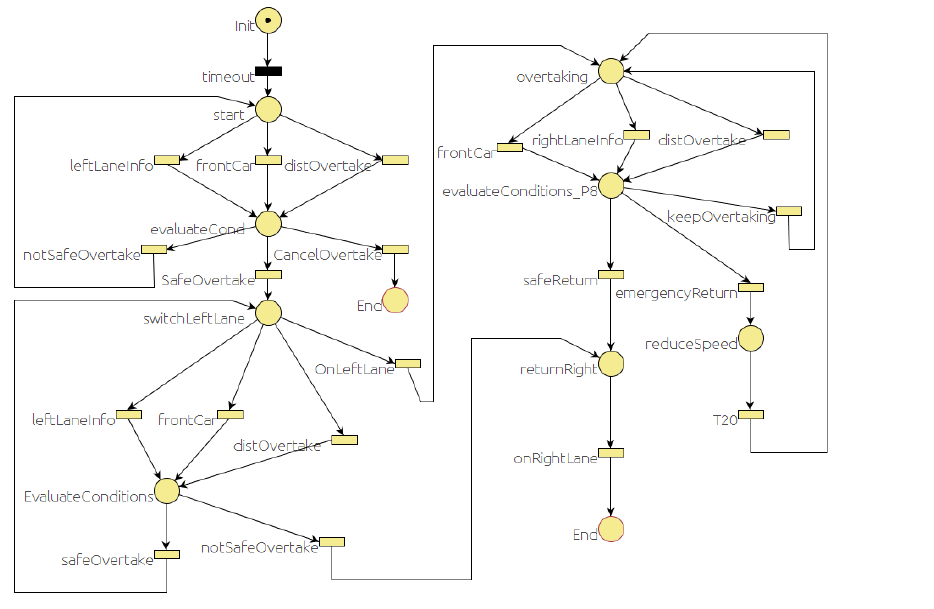
Figure 9. Overtake behavior